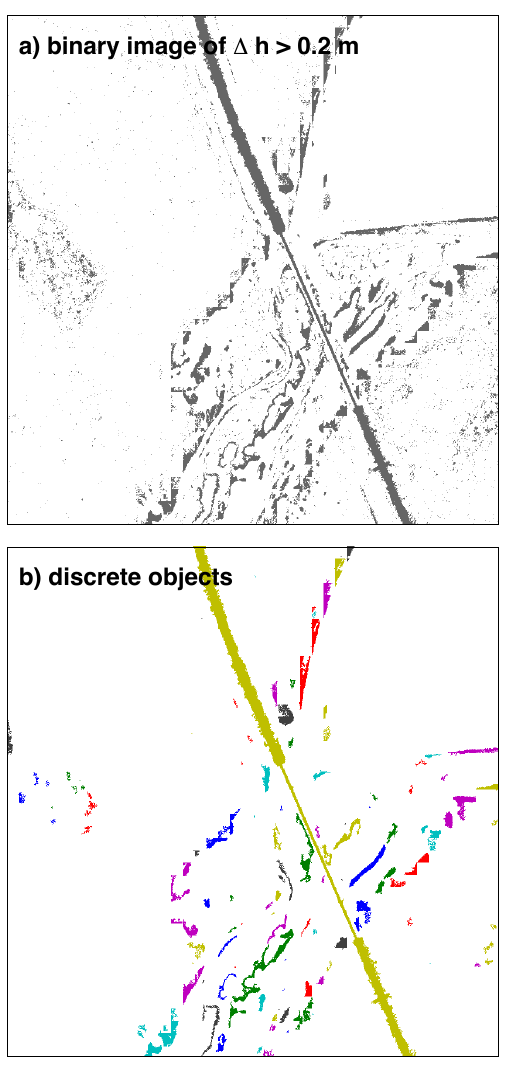
Figure 3. Binary image (a) of difference data set from Fig. 2b, which can be used to identify separate objects, shown in colors in (b) . Note that objects smaller than 20 fine-grid cells in (a) have been eliminated in (b)